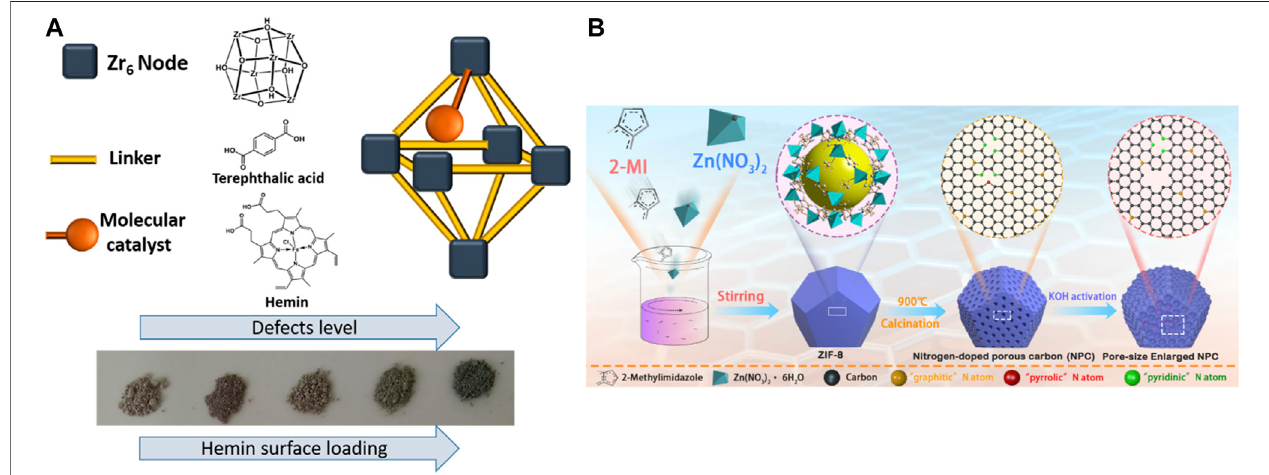
FIGURE12|(A) Fe ‒ porphyrin ‒ based(Hemin) ‒ modi fi edUiO ‒ 66(UiO ‒ 66@Hemin)madebydefectiveUiO ‒ 66(Shimonietal.,2019). (B) Schematicdiagramofthe synthesis of the pore size ‒ enlarged NPC nanomaterials derived from ZIF ‒ 8 precursors (Zhu et al., 2019).